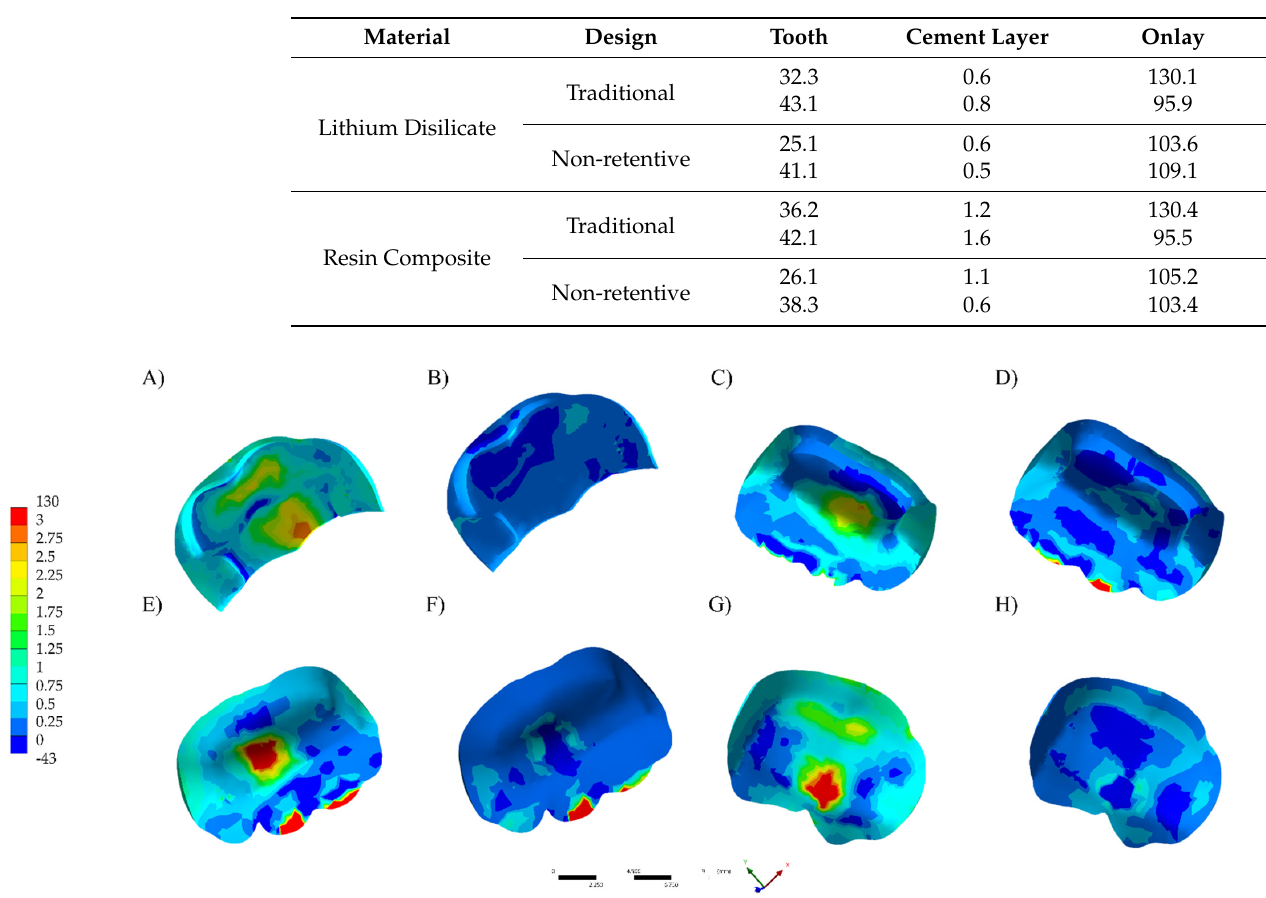
Table 2. Stress peaks (MPa) measured for each geometry according to the preparation and restorative